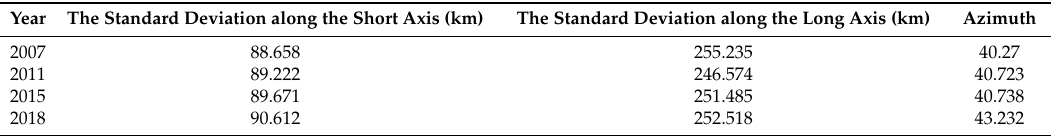
Figure 5. Standard deviation ellipse of the urban eco-efficiency and mean center transfer in the lower reaches of the Yellow River. ( a ) Distribution of the standard deviation ellipse of the urban eco-efficiency in the lower reaches of the Yellow River. ( b ) Mean center transfer curve of the urban eco-efficiency in the lower reaches of the Yellow River. Table 2. Standard deviation ellipse of the urban eco-efficiency in the lower reaches of the Yellow River for the period of 2007–2018.